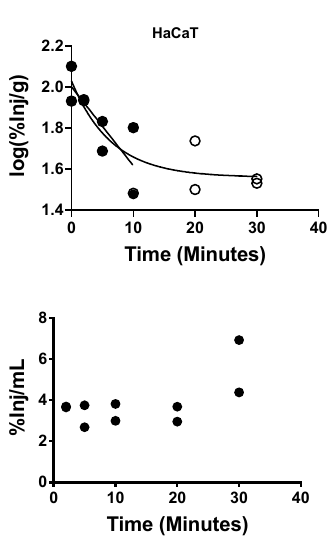
Figure 8. Brain-to-blood efflux of HaCaT-derived exosomes after ICV administration. Upper panel : open circles show that exosome clearance from brain had a half-life of 7.85 min; open circles show that exosomes reach an equilibrium after about 10 min. Lower panel : Appearance of HaCaT exosomes in blood was stable at a mean of 3.9%.